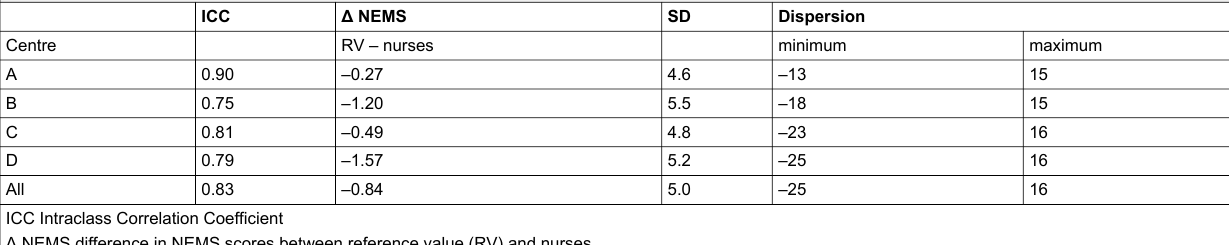
Table 4: Agreement of nurse assessed NEMS sum-scores according to the ICU